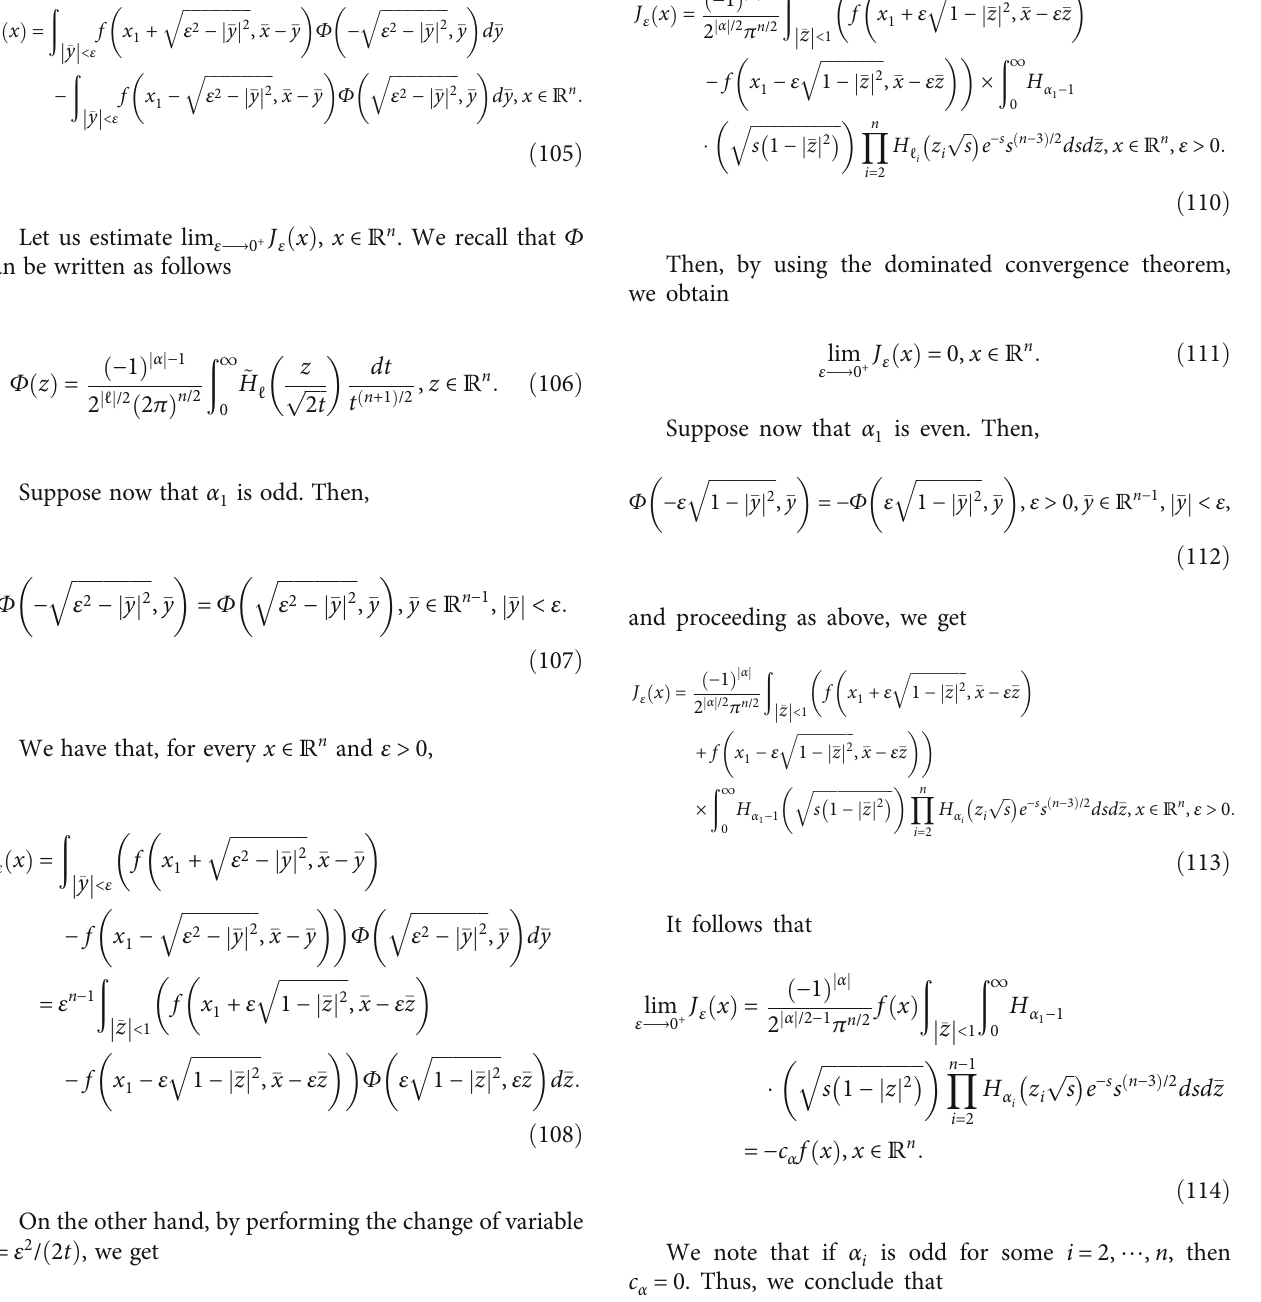
p ffiffiffiffiffiffiffiffiffiffiffiffiffiffi 1 − (cid:2) z j j 2 ffiffiffiffi